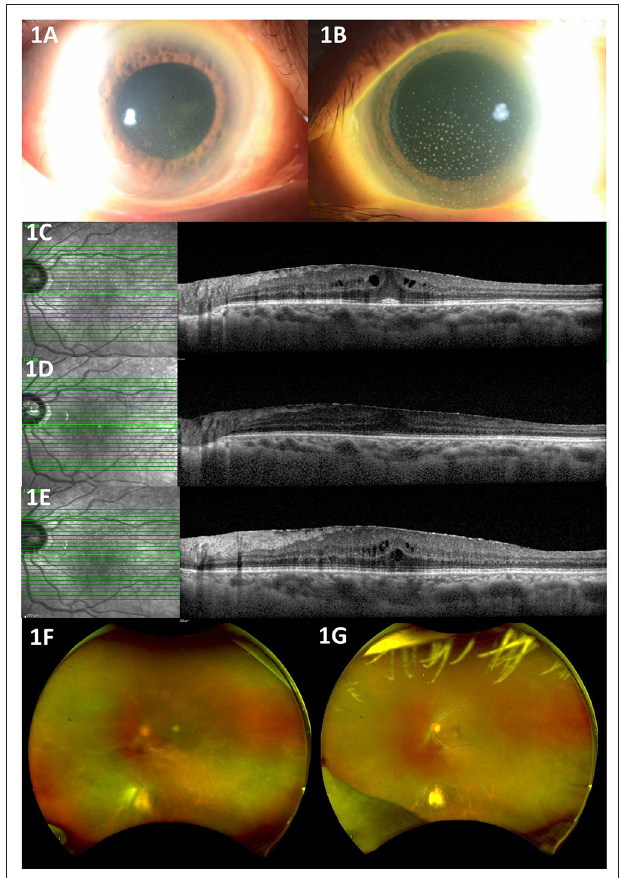
FIGURE 1 | (A) Non-infectious anterior uveitis with fine diffuse keratic precipitates in Patient #2. (B) Granulomatous keratic precipitates in Patient #4. (C) Cystoid Macula Edema after COVID-19 vaccination in Patient #1. (D) Resolution of Cystoid Macula Edema with treatment in Patient #1. (E) Recurrence of Cystoid Macula Edema after COVID-19 booster in Patient #1. (F) Reactivation of toxoplasma chorioretinitis after COVID-19 vaccination in Patient #5. (G) Resolution of toxoplasma chorioretinitis with treatment in Patient